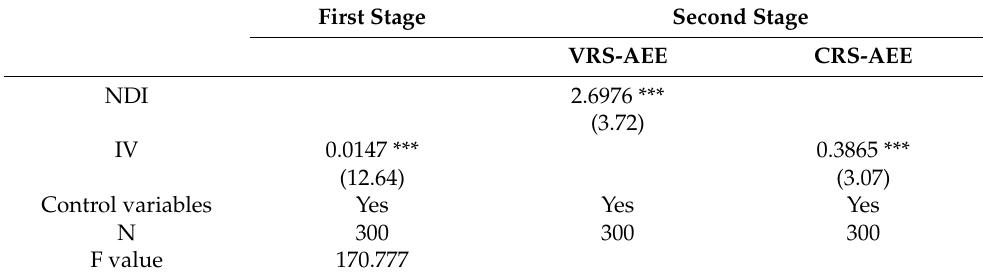
Table 10. Endogeneity